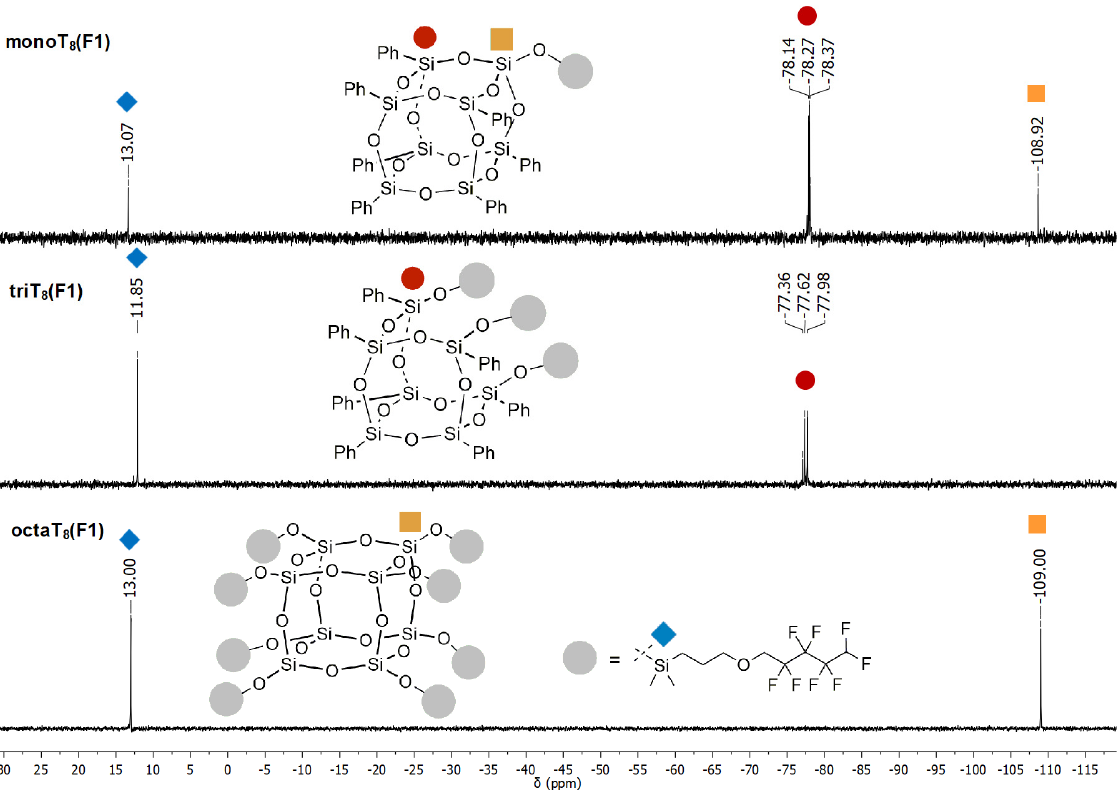
Figure 3. Selected range of stacked 29 Si NMR spectra of DDSQ-2Si(F1) and DDSQ-4Si(F1) . Additionally, the methodology for the synthesis of the fluorinated silsesquioxanes was also verified in terms of the reverse Si-H and Si-CH=CH 2 reactive groups placement, PATH B, i.e., hydrosilylation of SQ-Vi ( monoT 8 SiVi , triT 7 SiVi , DDSQ-2SiVi , DDSQ- 2OSiVi , DDSQ-4OSiVi , octaT 8 SiVi ) by three types of silanes containing respective fluorosubstituents to olefins used before ( F3 – F5 ) (Scheme 1). The reaction conditions were